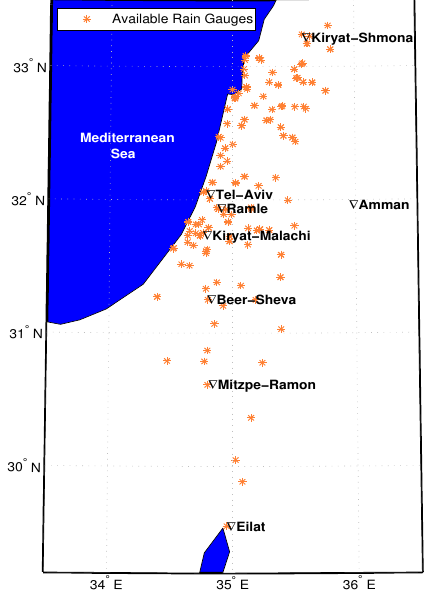
Figure 3. Distribution of the 70 available rain gauges; each orange asterisk indicates a rain gauge